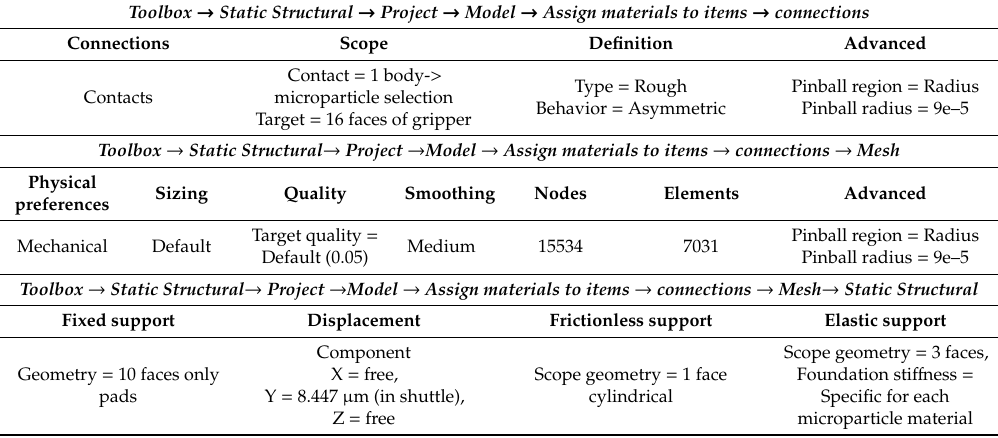
Table 12. Simulation conditions for the manipulation of the microparticles, using Ansys Workbench. Toolbox → Static Structural → Project → Model → Assign materials to items →